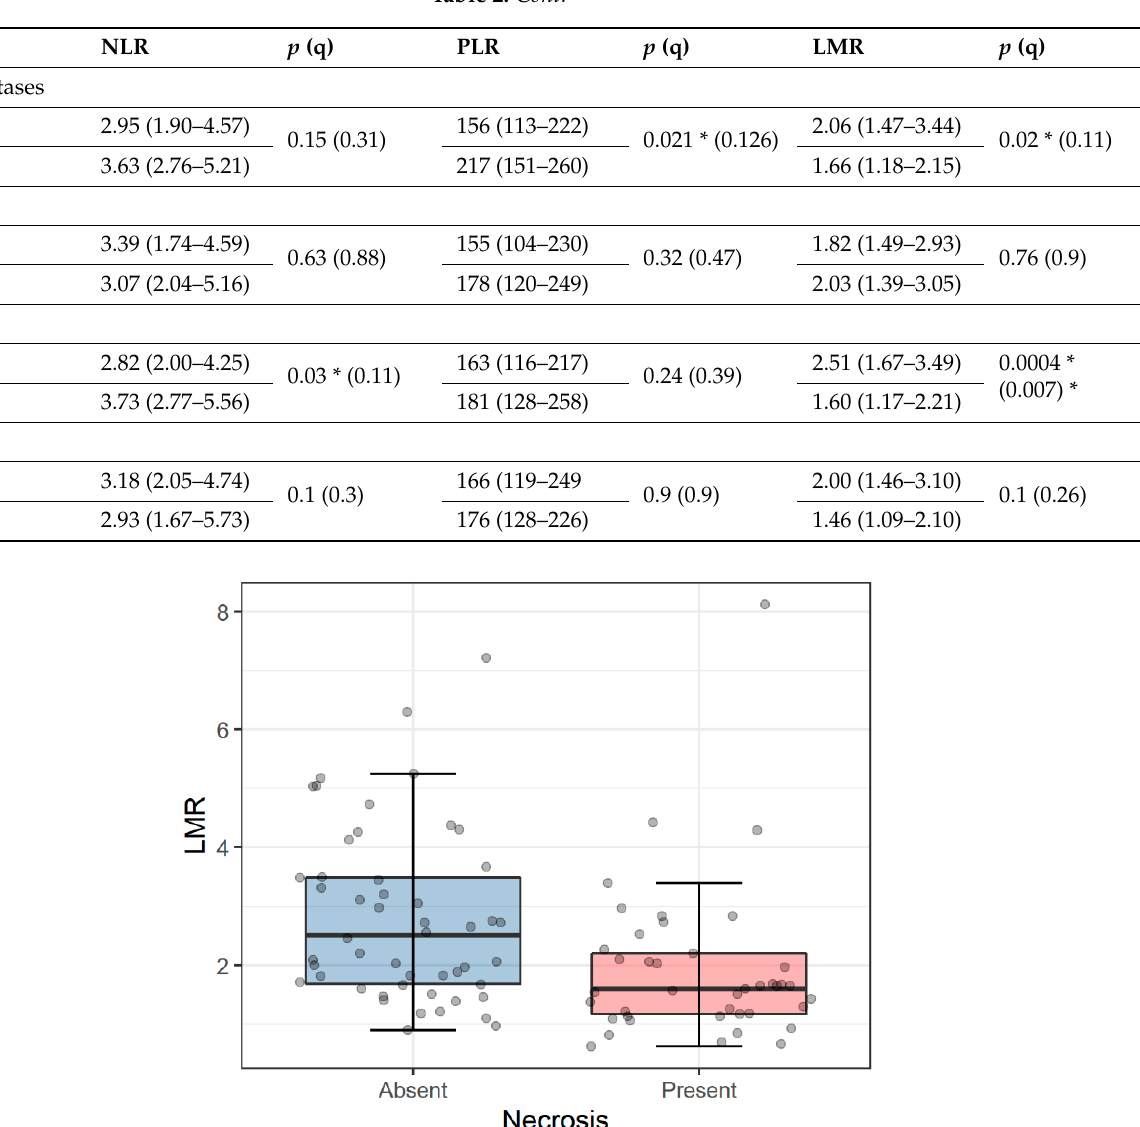
Figure 1. Associations between LMR and tumor necrosis. The presence of necrosis was associated with significantly lower LMR ( p = 0.0004, Mann-Whitney U test). Horizontal lines inside boxes show median values. The lower and upper hinges correspond to the first and third quartiles (the 25th and 75th percentiles). Upper and lower whiskers indicate 1.5 interquartile range of the lower and upper quartile, respectively. Circles represent individual measures. Abbreviations: LMR: lymphocyte-to- monocyte ratio; PLR: platelet-to-lymphocyte.